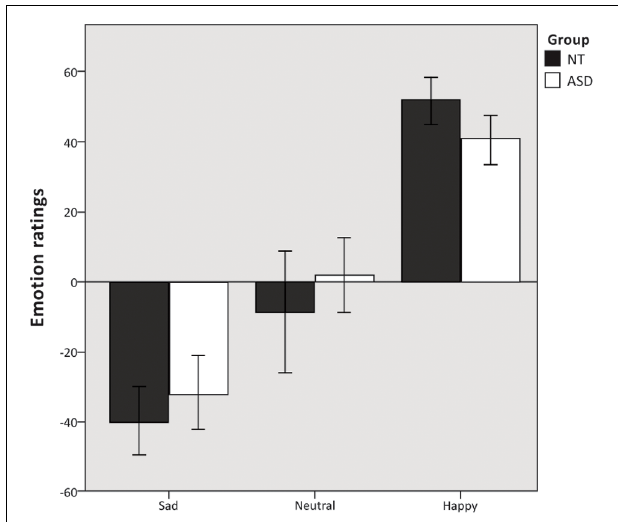
FIGURE 2 | Emotion ratings. Mean emotion ratings (on a visual analog scale from − 100 to 100) of sad, neutral and happy musical excerpts. Error bars indicate 95% confidence intervals.